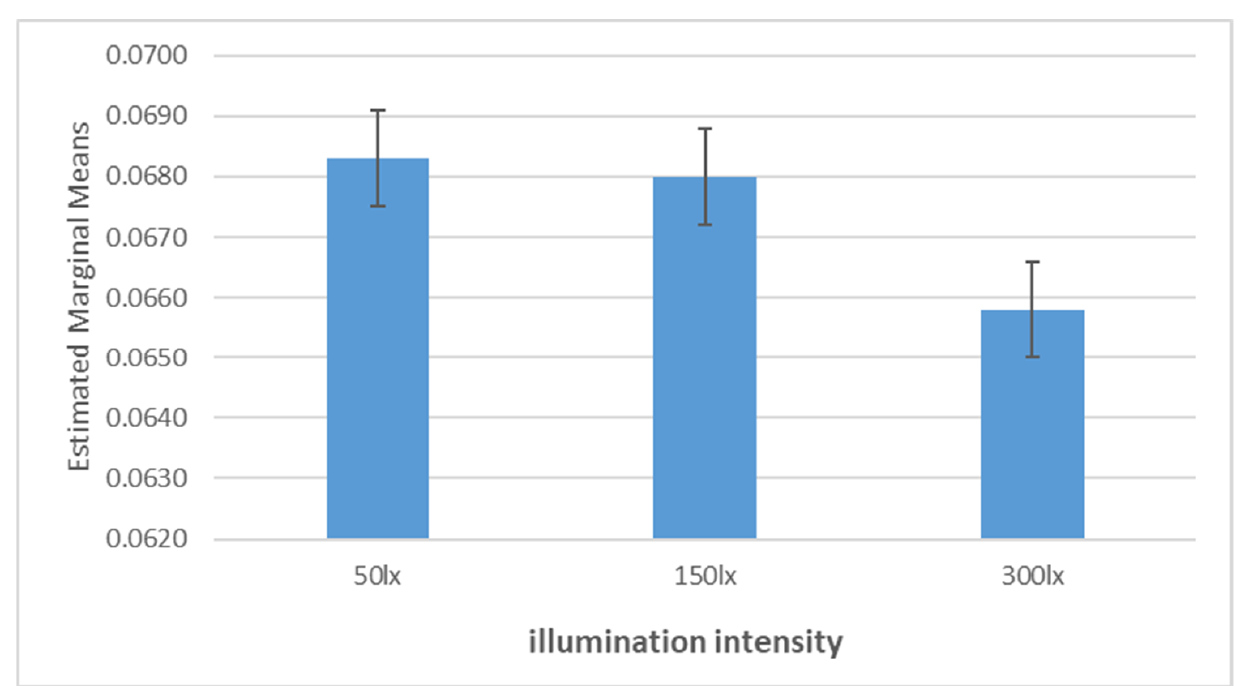
Figure 7. Effect of illuminance on the variation coefficient for pupil diameter.